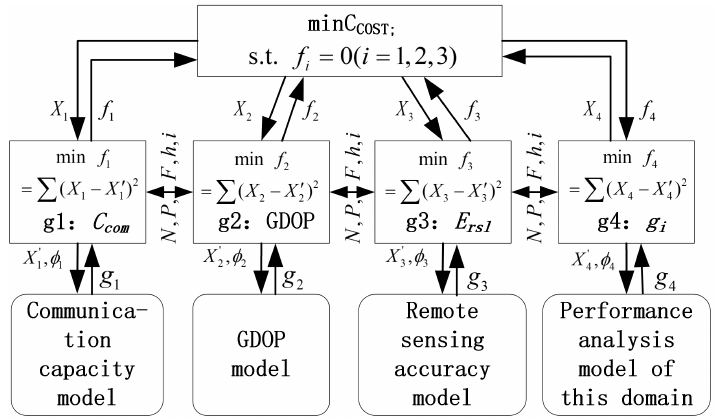
Figure 1. Structure diagram of multidisciplinary collaborative design for